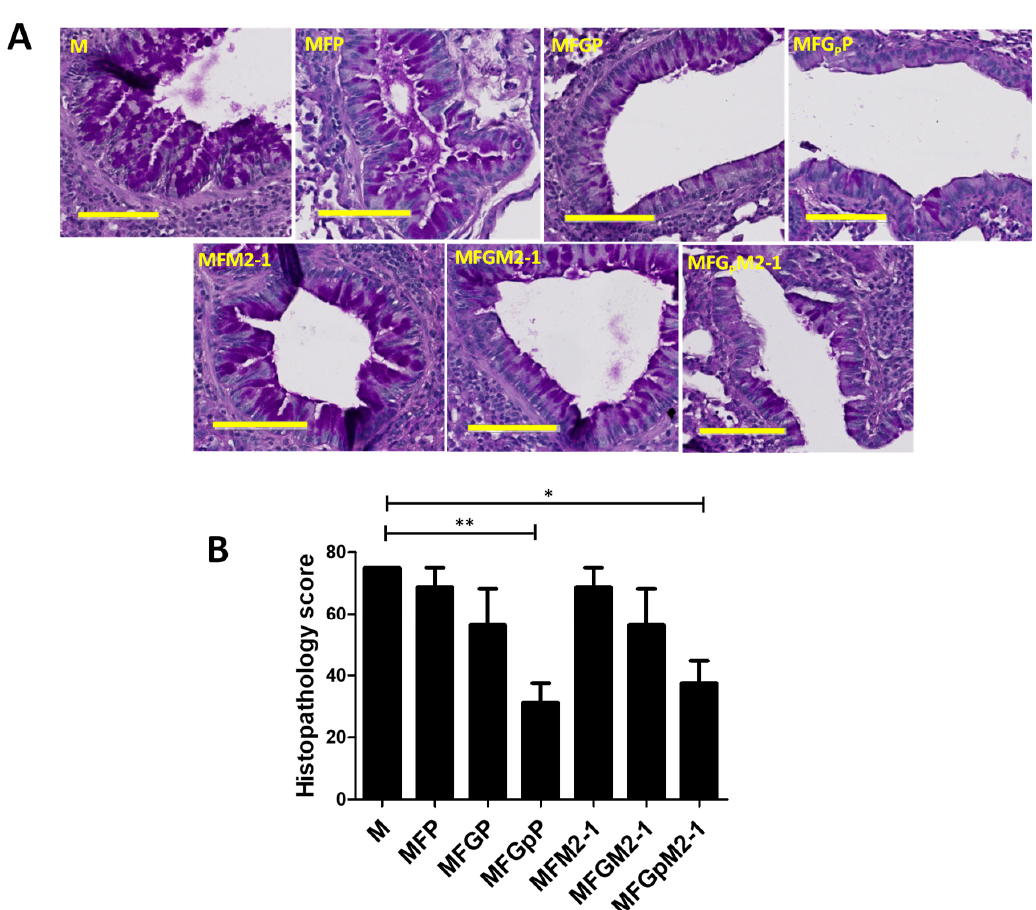
Figure 6. Immunized animals show a significant reduction in lung inflammation. Female BALB/c mice (4–6 weeks) were divided in 7 groups ( n = 4), immunized, and challenged as summarized in Table 2. Lungs were collected, fixed, and stained with periodic-acid Schiff (PAS) staining as described in the materials and methods. The slides were analyzed by Aperio ImageScope software and scored blindly on a 0–4 scale and subsequently converted to a 0–100% histopathology, Bar = 100 μ m scale. ( A ) Representative images from corresponding groups. ( B ) Quantitative data converted from histopathology scale. * p < 0.05, ** p < 0.01. Note the VLPs with Gp appeared most effective at reducing lung mucin levels.